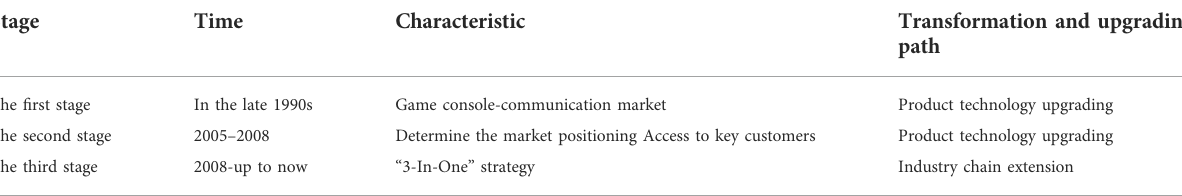
TABLE 2 Analysis of the transformation and upgrading stages of Shennan